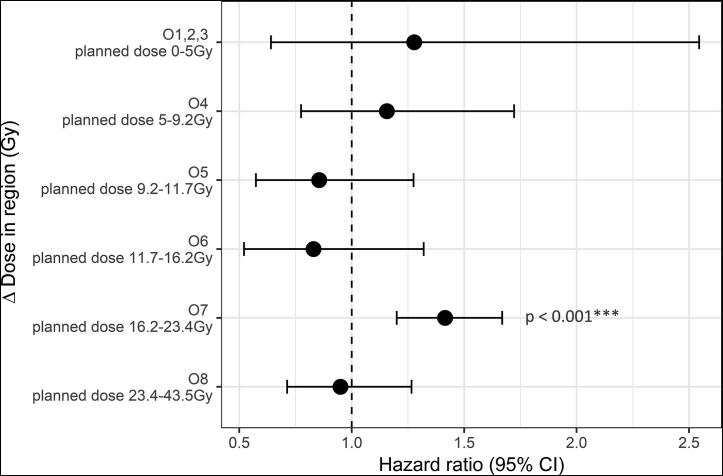
Forest plot showing the hazard ratios and 95% confidence intervals of the mean Δdose in the identified heart region found from multivariate analysis in each planning dose octile. Δdose is only significant in the 7th octile, suggesting a dose threshold for heart damage exists in the range of 16.2–23.4 Gy.